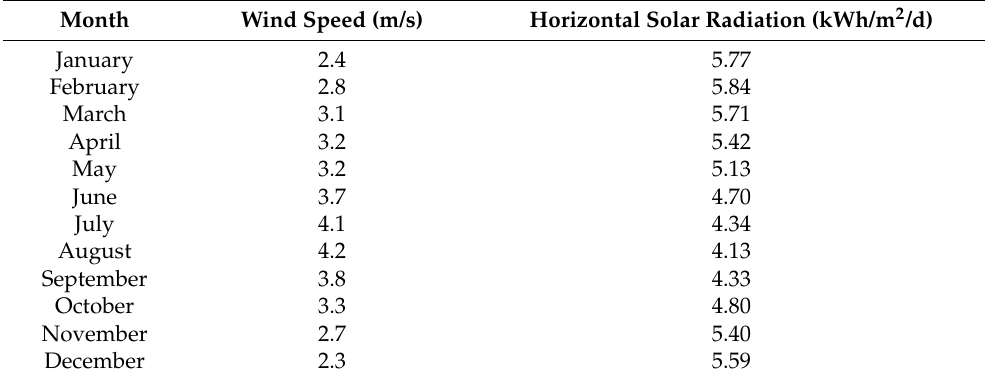
Table 1. RETScreen wind speed and solar radiation values for Okorobo-Ile